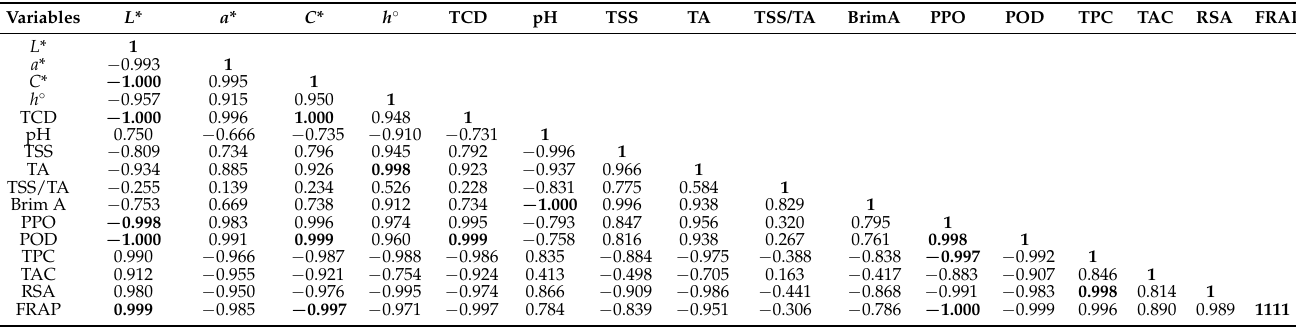
Correlation values in bold are significant at p < 0.05. TPC, total phenolic content; TAC, total anthocyanin content; RSA, radical scavenging activity; FRAP, ferric reducing antioxidant power; PPO, polyphenol oxidase; POD, peroxidase; L *, lightness; a *, redness; C *, chroma; h ◦ , hue angle; TCD, total colour difference; TSS, total soluble solids; TA, titratable